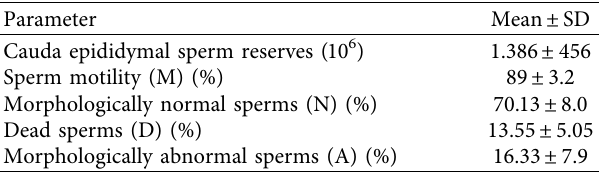
Table 4: Cauda epididymal sperm